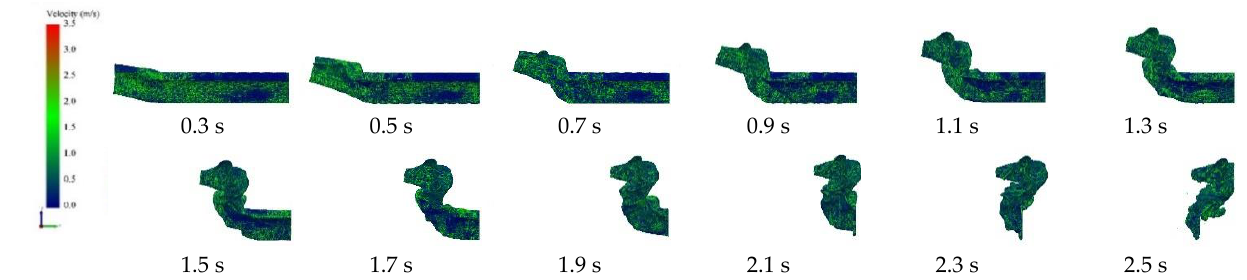
Figure 9. Film shapes at different times under the action of the hug plate film-lifting parts. As shown in Figure 9, in 0.3~0.5 s, the mulch film is gradually lifted, and the defor- mation of the mulch film is gradually increased, that is, the hug plate film-lifting parts enter the simulation model. The velocity of the film particles is higher the closer they are to the film-lifting parts, and the maximum velocity of the film particles mainly occurs at the front of the film-lifting parts. In 0.7~2.5 s, the mulch film is gathered forward, curled and gathered in front of the film-lifting parts, and the amount of aggregation gradually increases, and the damage of the mulch film is relatively small. The main reason is that, during the operation, the mulch film was pushed forward under the joint action of the hug plate film-lifting parts and the soil particle aggregates that did not penetrate the gaps between the film-lifting parts. The gap between the individuals of the hug plate film-lifting parts is larger than that between the third-order shovel film-lifting parts. Compared with the third-order shovel film-lifting parts operation, the hug plate film-lifting parts operation process lifts less soil, and the soil particle aggregates flow to the rear through the gap between monomers after disaggregation, which has less impact on the promotion of the mulch film, making the larger area of the mulching film subject to the gathered effect of the film-lifting parts, and the gathered effect was obvious in the horizontal operation direction (positive Y-axis direction). The simulation process shows that the hug plate film-lifting parts can lift the mulch film as a whole, and the film-lifting process contains less soil, which is convenient to use with the eccentric film-lifting roller, which can better complete the collection of the mulch film roll and is more conducive to simplifying the subsequent plastic-film impurity separation device.